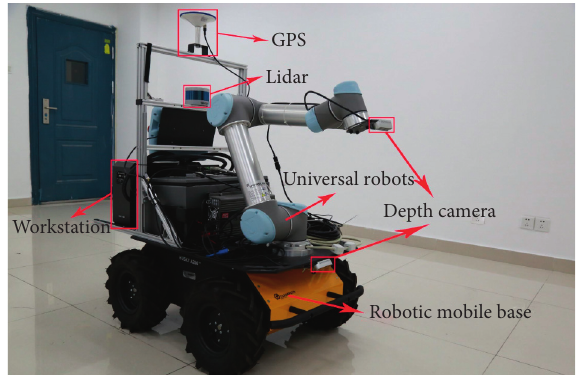
Figure 4: Schematic design of the overall structure with the weeding robot for corn-weed detection. GPS is responsible for providing outdoor navigation information for agricultural mobile robots. Lidar is responsible for further providing precise navigation information for robotic mobile base. Depth camera is responsible for multitarget depth ranging and shortest path planning. Universal robots are responsible for carrying weeding actuators for multitask weeding operations. Robotic mobile base is responsible for au- tonomous movement in the cornfield as a mobile carrier. Work- station is responsible for deploying the algorithm program and communicating with the abovementioned key